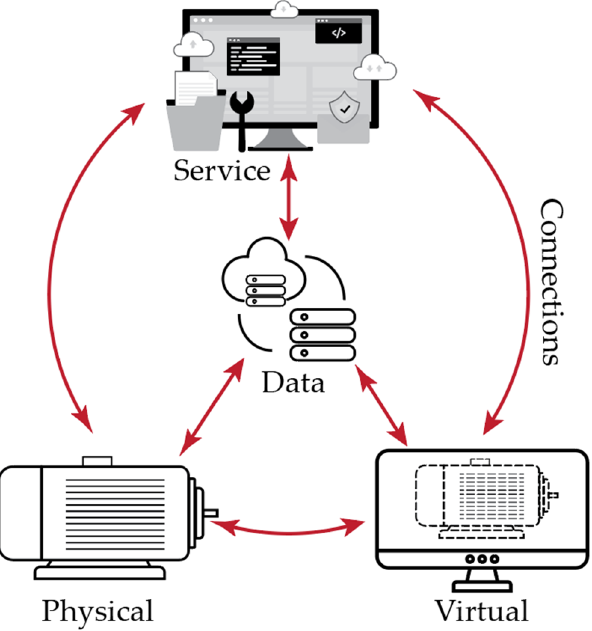
Figure 1. Five-dimensional DT model as proposed in literature [8].